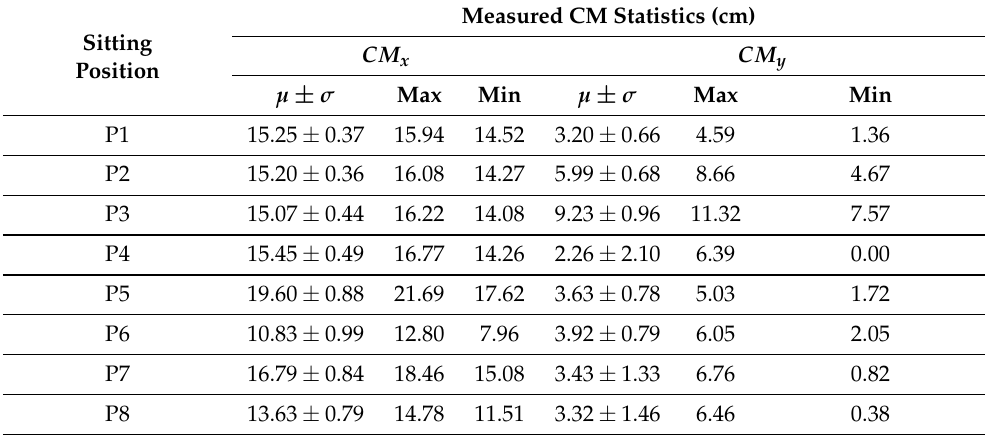
Table 4. Statistical analysis of the measured center of mass coordinates for each sitting position evaluated.